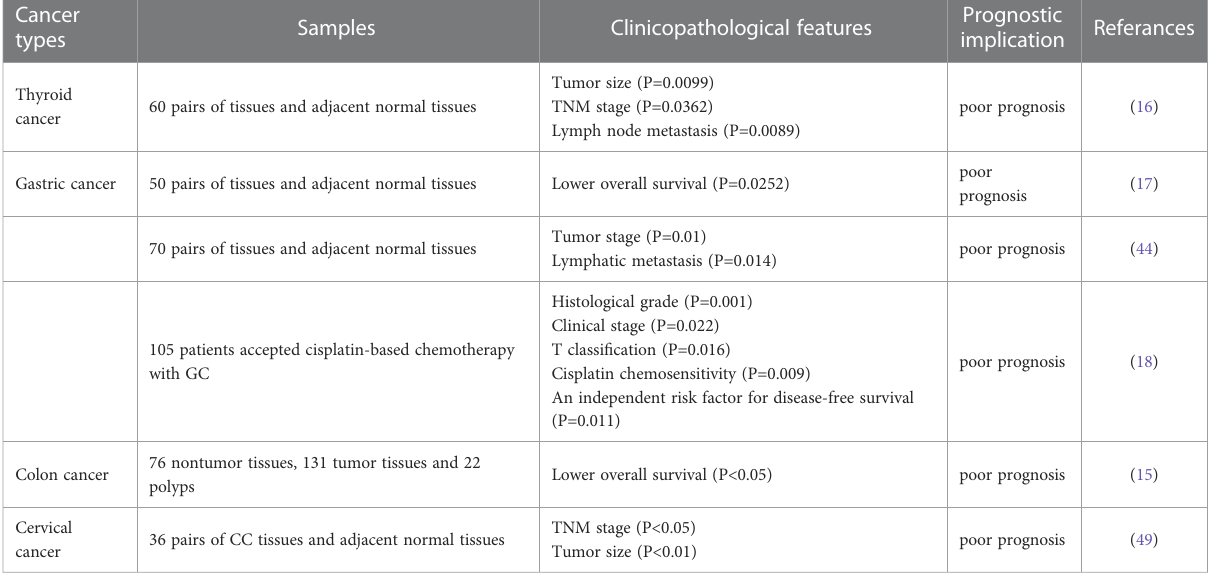
TABLE 2 Clinical pathological features and prognostic signi fi cance of circCCDC66 in malignant tumors. Cancer